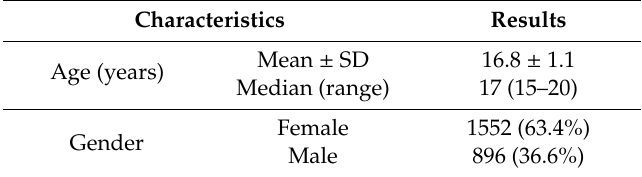
Table 1. The general characteristics of the sample of adolescents studied within the PLACE-19 Study ( n =